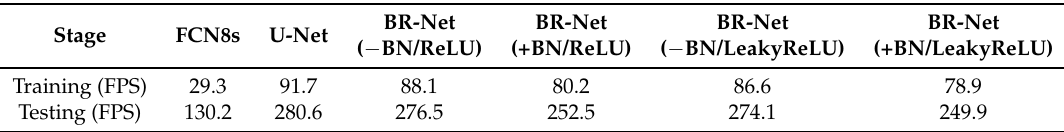
Table 2. Comparison of computational efficiency of FCN8s, U-Net, and BR-Net with various combinations of